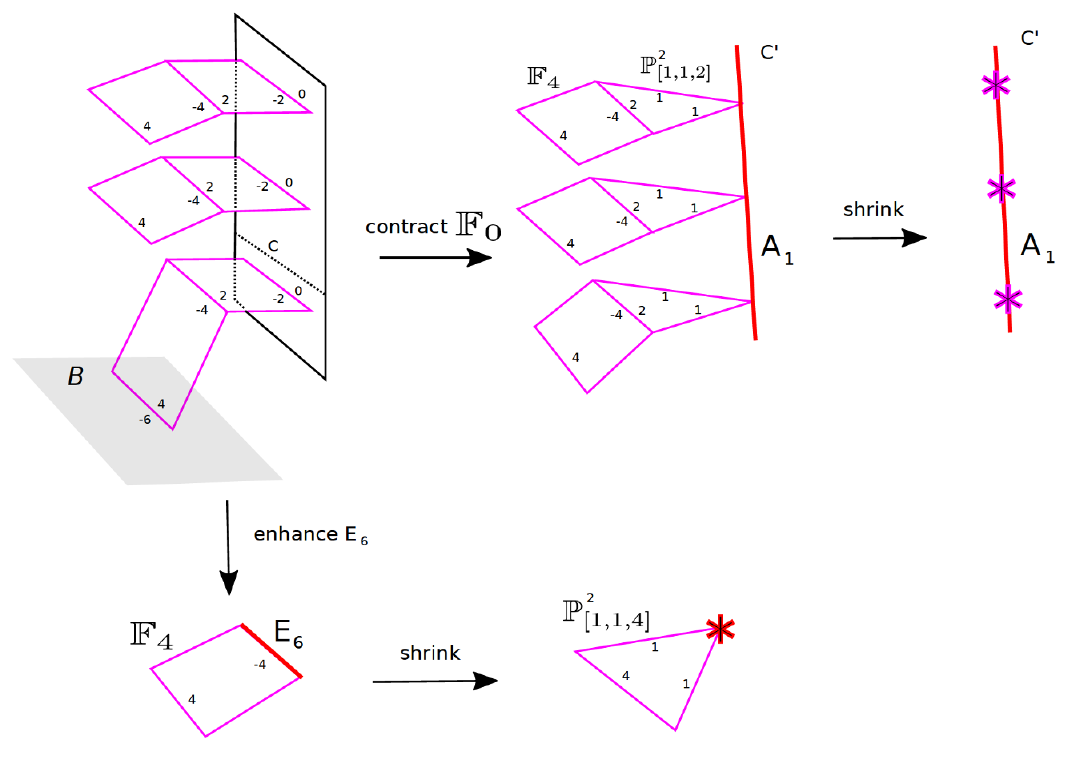
Figure 4 . Geometry of the (cid:0) 6 theory. The base of the elliptic (cid:12)bration is the noncompact surface B . For each P 1 with a non-trivial self-intersection number inside a given surface, the latter is indicated within the corresponding surface. In the 5D limit, the A 1 locus and P 2